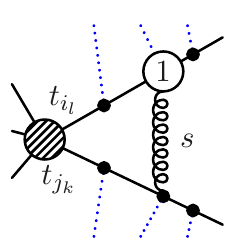
(1) (1) or along collinear YM (cid:24) L L